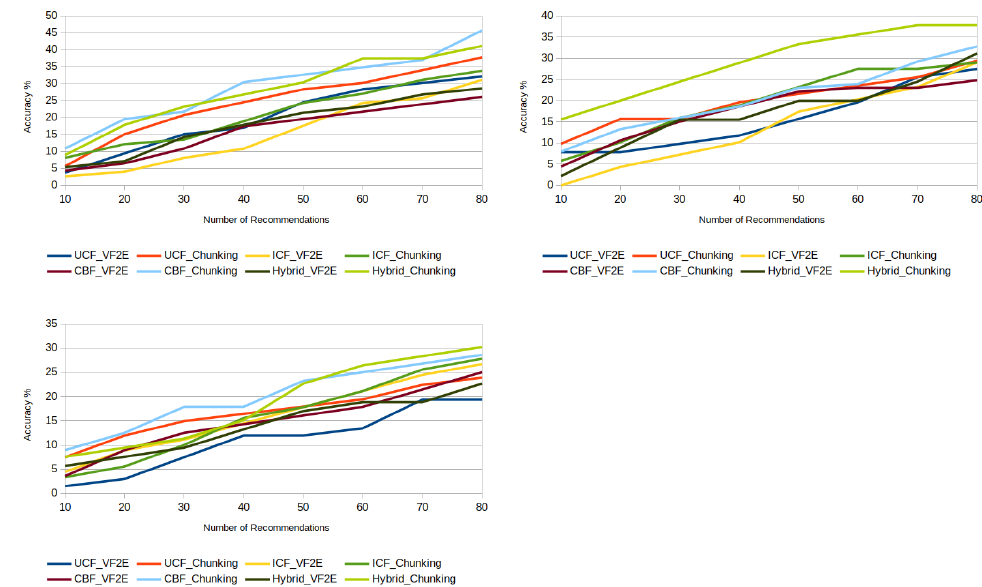
Figure 7. Comparison among our proposed techniques (Chunking) with baseline methods (VF2E) for a group of three users in each graph (combined). The red, green, blue, and light green lines show the performance score of our proposed methods UCF_Chunking, ICF_Chunking, CBF_Chunking, and Hybrid_Chunking methods over the various baseline methods of